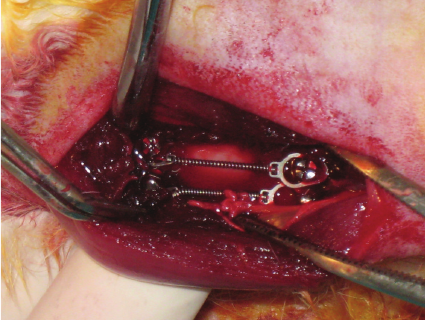
Figure 3: Four Miniscrews after 115 G of force applied with a nickel- titanium closed-coil